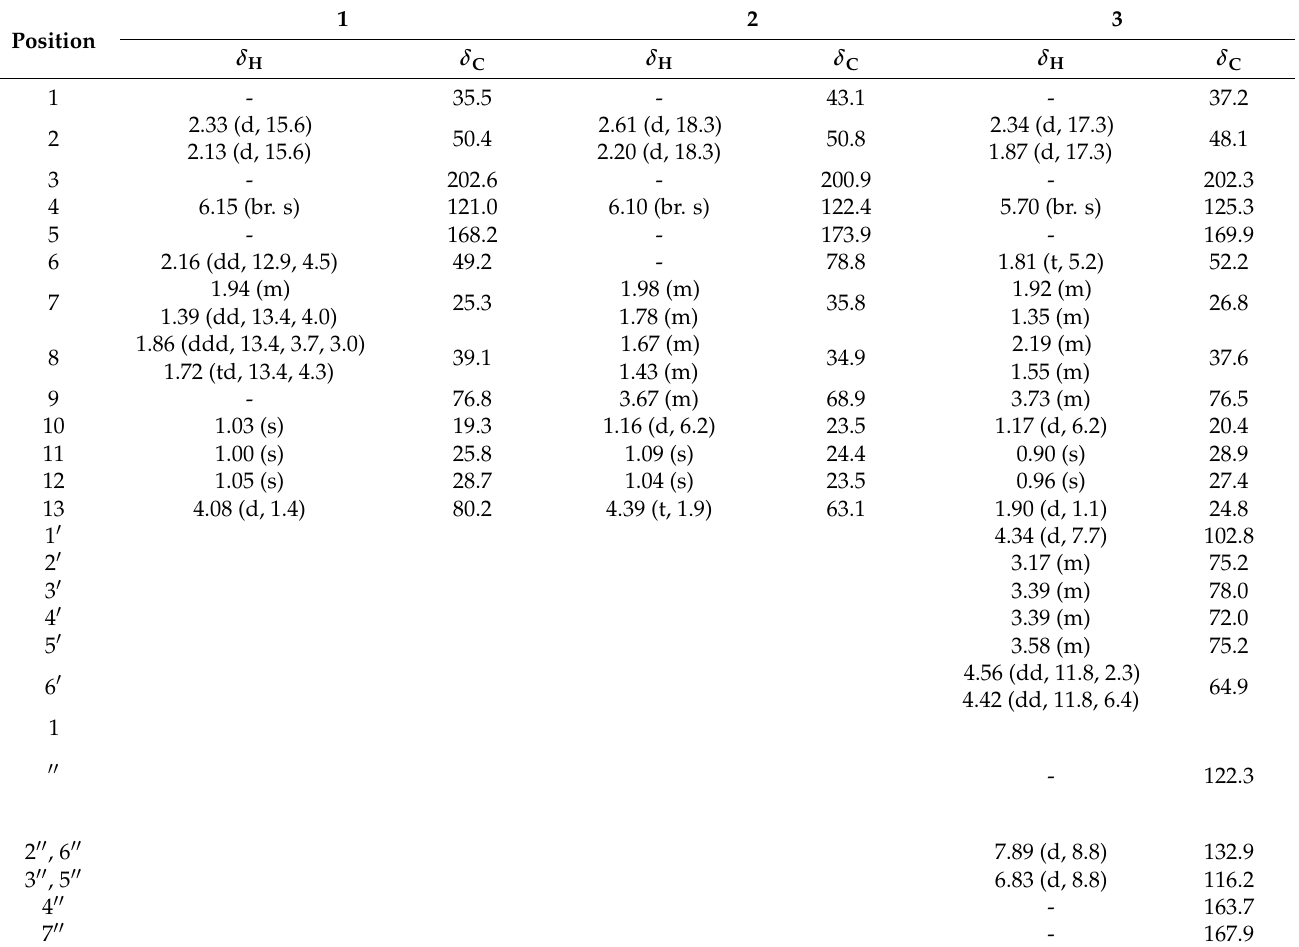
Figure 4. Plausible biogenetic pathway for compound 1 . Table 1. 1 H-NMR (600 MHz, methanol- d 4 ) and 13 C-NMR (150 MHz, methanol- d 4 ) of compounds 1 – 3 ( δ in ppm, J values in